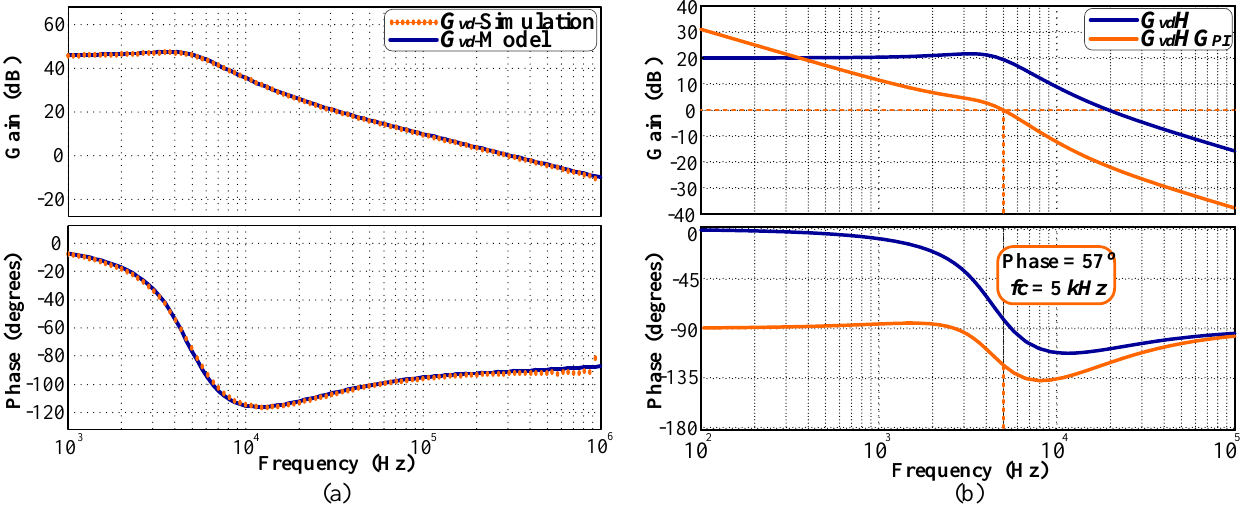
Figure 7. Frequency analysis of 3SSC-A-based buck converter: ( a ) Validation of transfer function G vd ( s ) ; ( b ) Open-loop